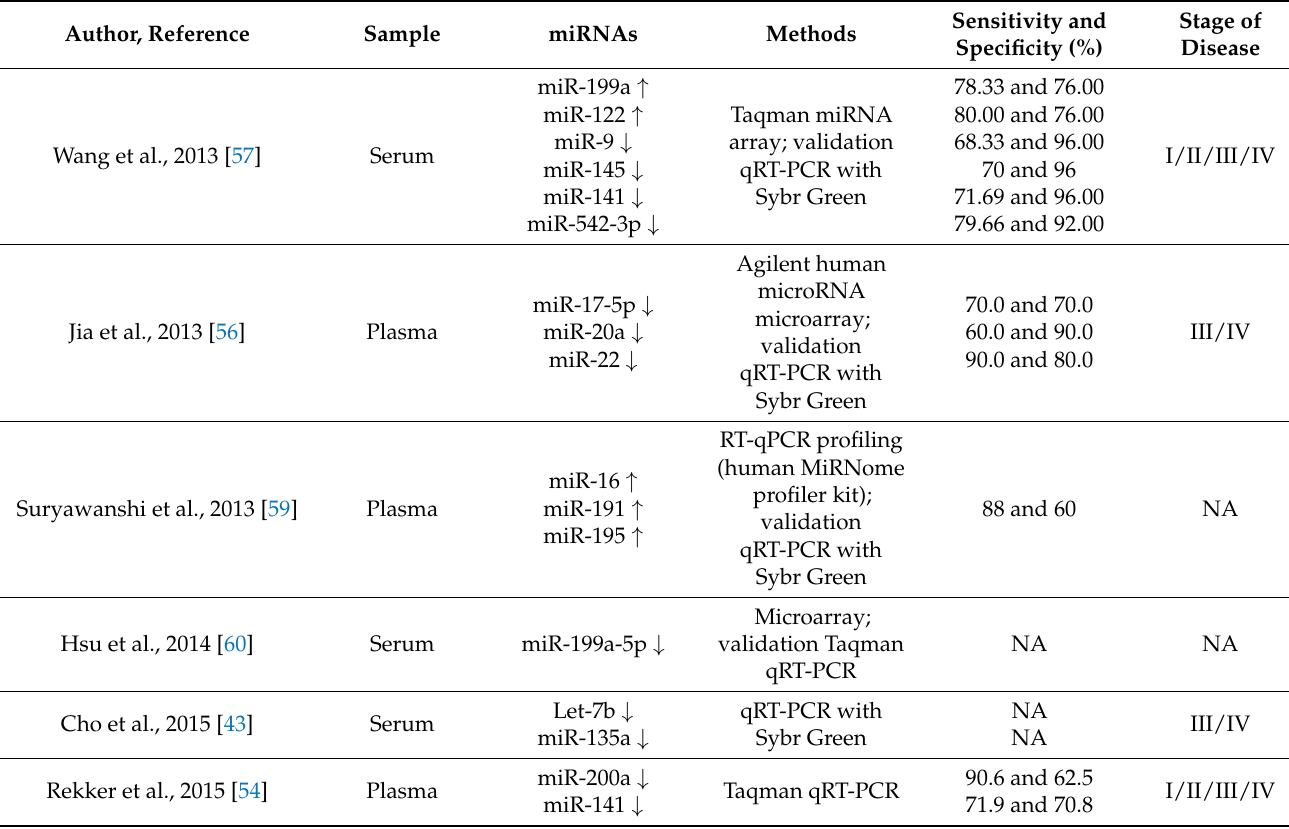
Table 1. Differentially expressed plasma, serum, and salivary miRNAs in patients with